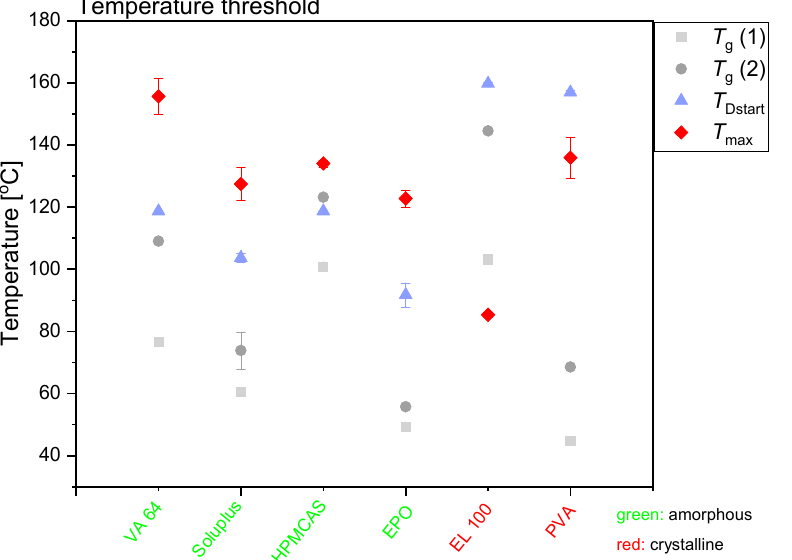
Figure 3. Schematic depiction for the definition of the temperature threshold for the different drug–polymer compact compositions. Compacts containing the green polymers became fully amorphous upon exposure to laser radiation and compacts containing the red polymers did not become fully amorphous. T g 1 is the temperature of the T g for the polymer with bulk water. T g 2 is the temperature of the T g for the water-free polymer. T max is also shown in Figure 1. T Dstart is determined from the drug–polymer solubility measurements. Mean ± SD ( n = 2 for T g 1, T g 2, and T Dstart , n = 3 for T max ). Table 2. Glass transition temperatures ( T g ) (°C) of the polymers. Polymer